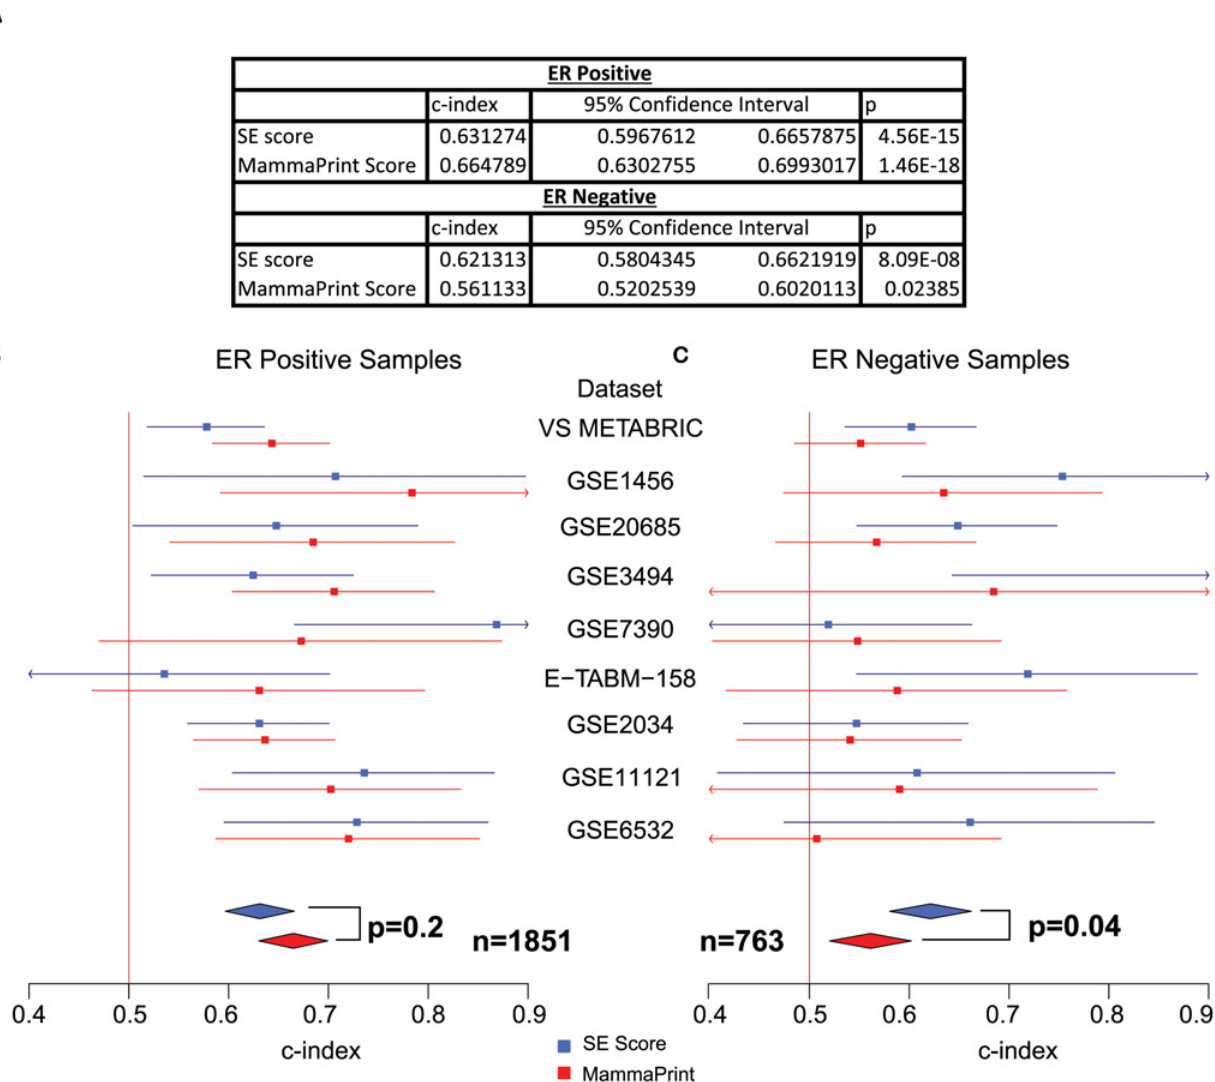
Fig 4. Meta-analysis comparison of the breast cancer SE score with MammaPrint. A) Survival analysis statistics for the SE score and MammaPrint over ER positive samples and ER negative samples separately, c-index denotes concordance index and p denotes p -value. B) & C) The plots display the concordance index for the SE score and MammaPrint in each data set alongside 95% confidence intervals. The overall concordance indices were derived and compared via meta-analysis using a random effects model. The vertical line denotes concordance index = 0.5, data sets where the confidence interval for the concordance index crosses this line did not reach significance. Meta-analysis reveals that the SE score performs comparably to MammaPrint in ER positive samples (B) and outperforms MammaPrint across ER negative samples (C).